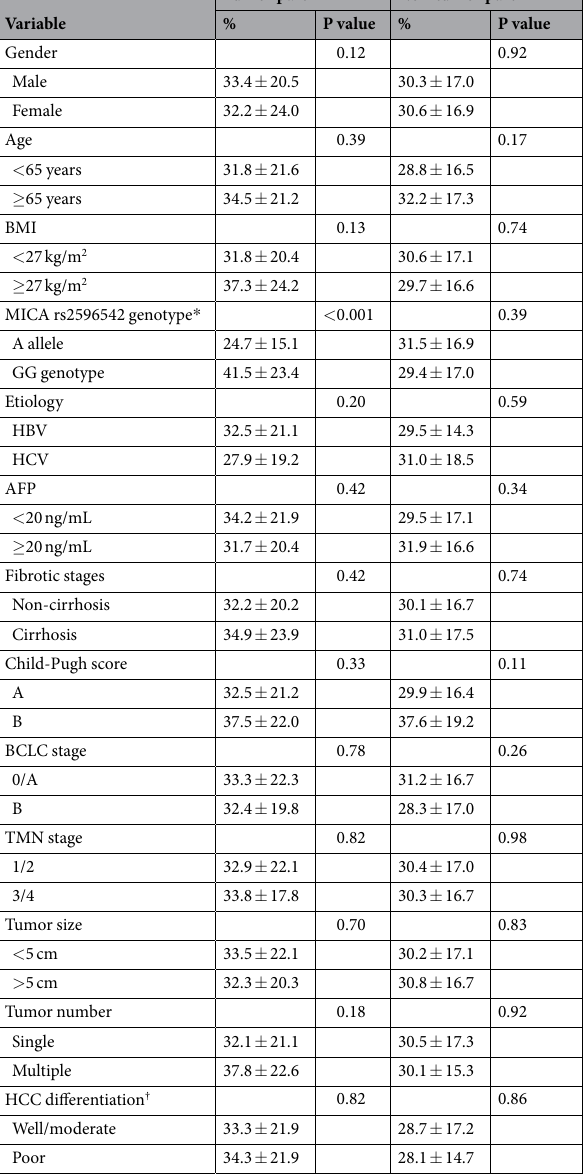
Table 2. MICA expression of the tumor and non-tumor part in patients with different characteristics. Note: BMI: body mass index.HBV: hepatitis B virus. HCV: hepatitis C virus. MICA: MHC class I chain-related A. BCLC: Barcelona Clinic Liver Cancer. HCC: hepatocellular carcinoma. * 6 patients had indeterminate single nucleotide polymorphism. † Data available in 119